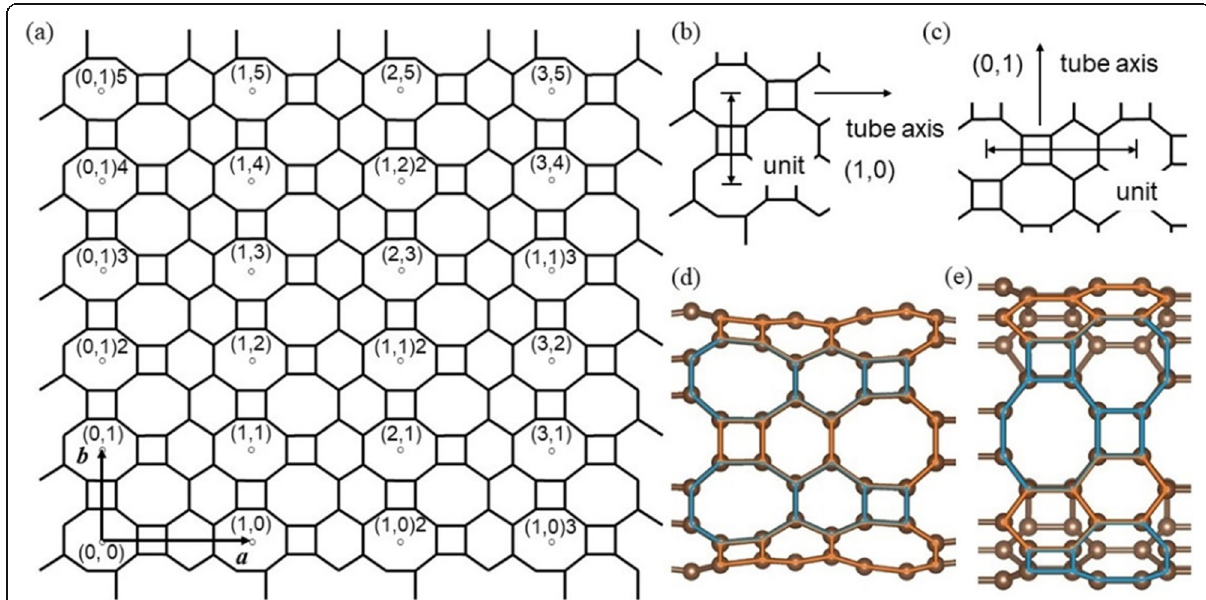
Fig. 3 ( a ) Different tubes are denoted by symbol ( l,m ) n , with ( l,m ) stands for rolling direction based on unit vector a and b , and n for the